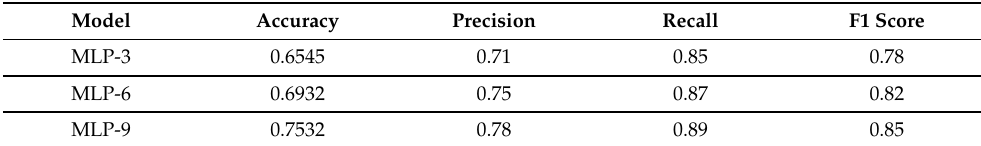
Table 7. Results using the multilayer perception with 3, 6, and 9 layers with deleted missing value data.